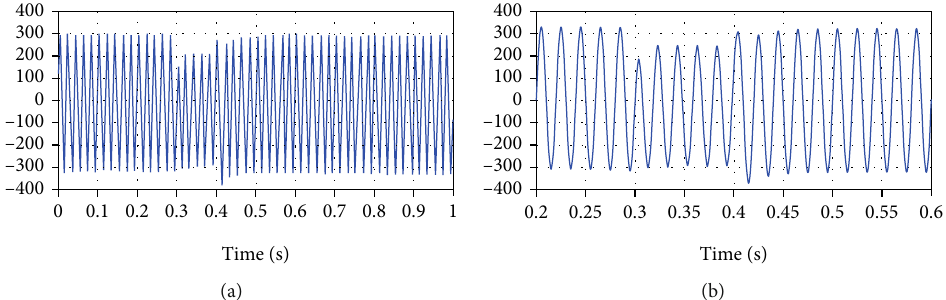
Figure 14: (a) Voltage v at the terminals of sensitive load after compensation; (b) zoom on this signal. L